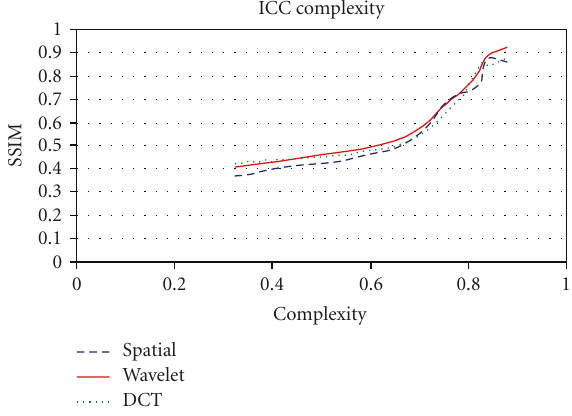
Figure 3: Relation between SSIM and ICC complexity measure (averaged on 2000 images).